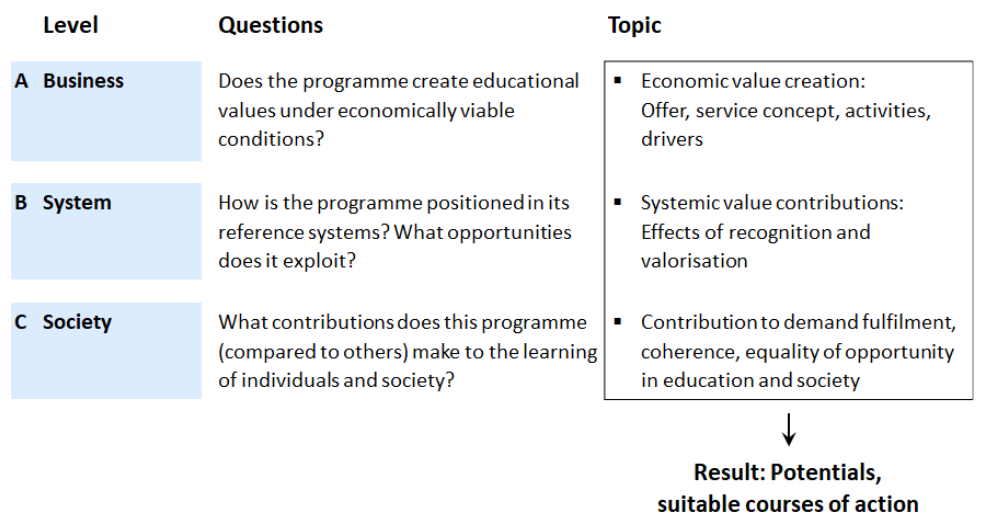
Figure 5. Analysis of the value creation potential of educational programmes on three levels (author’s own